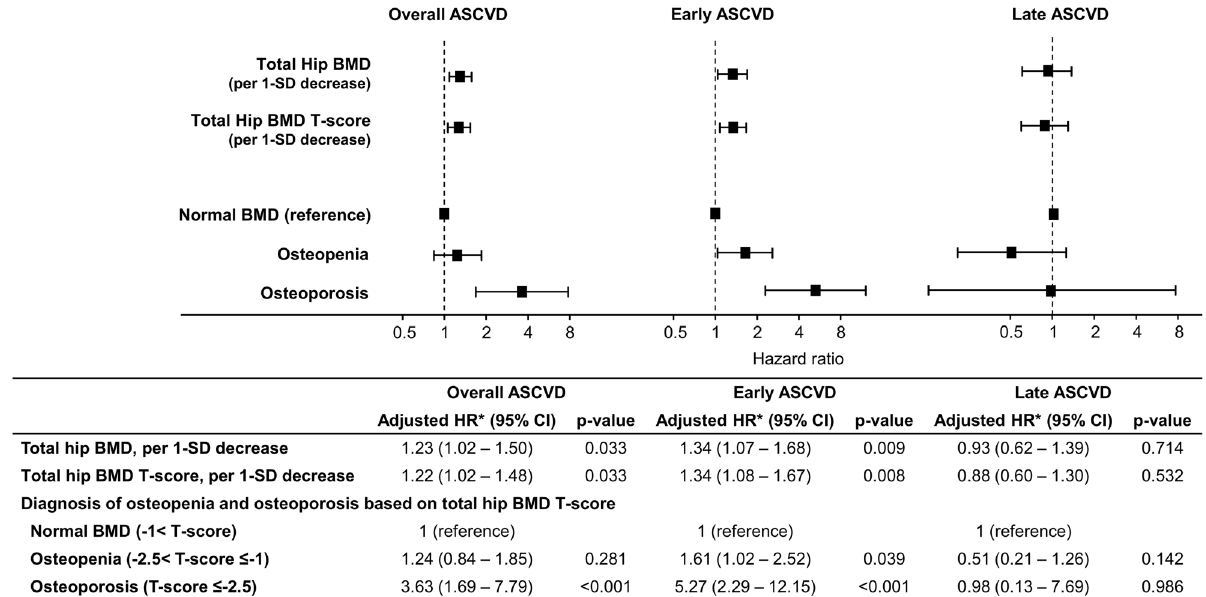
Figure 3. Independent predictors of ASCVD. Total hip BMD, BMD T-score, and a diagnosis of osteoporosis were independent predictors for the overall occurrence of ASCVD. The BMD and BMD T-score were independently associated with the risk of early ASCVD, but not late ASCVD. Similarly, the diagnoses of osteopenia and osteoporosis exhibited independent associations with the risk of early ASCVD, but not late ASCVD. ASCVD atherosclerotic cardiovascular disease, BMD bone mineral density, BMI body mass index, CI confidence interval, HR hazard ratio, SD standard